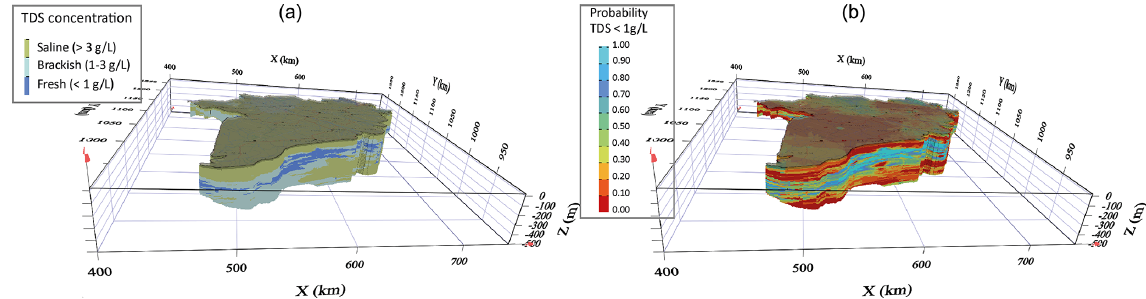
Figure 11. The 3D perspective view of the spatial distribution of fresh–brackish–saline groundwater (a) and the probability that TDS < 1gL − 1 (b) .